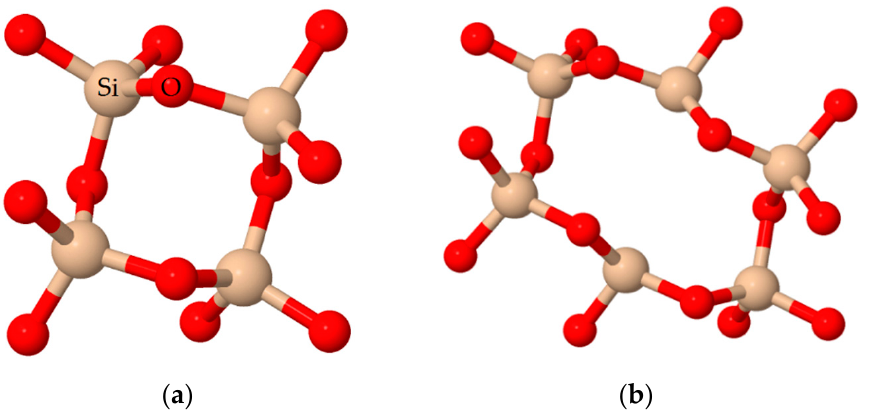
Figure 6. Predominant structures within the silica matrix of a xerogel prepared with TEOS: ( a ) (SiO) 4 rings, and ( b ) (SiO) 6 rings.